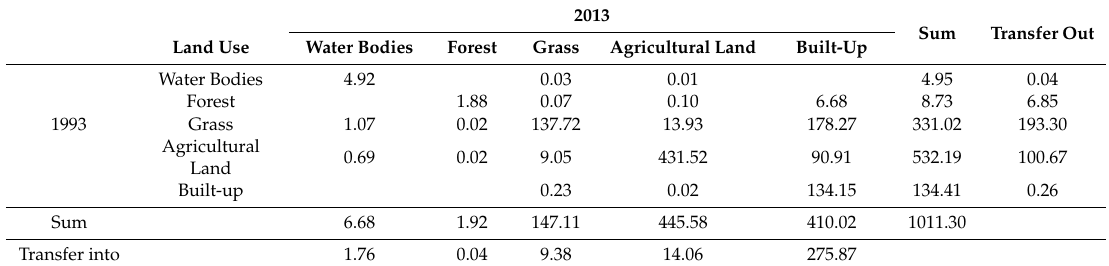
Table 3. Land Use Transfer Matrix of Zhengzhou from 1993 to 2013 (km 2